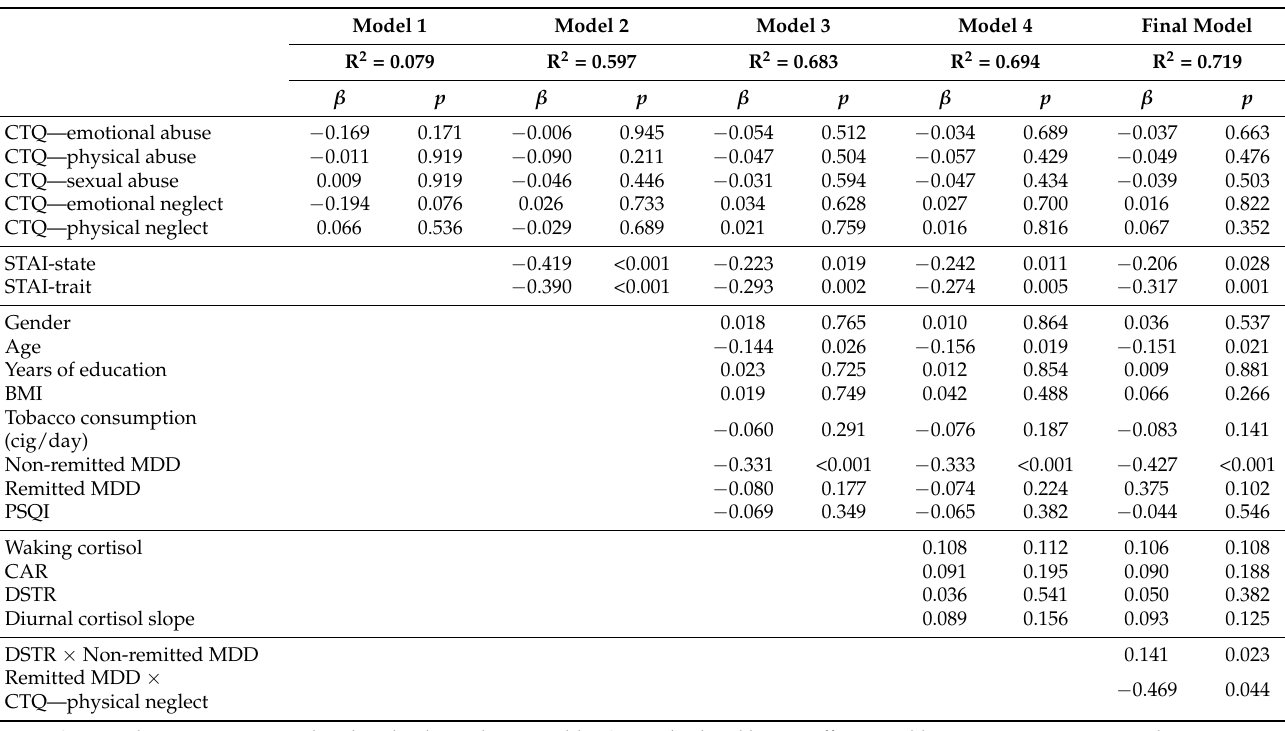
Table 3. Results of multiple linear regression analyses exploring the association of childhood maltreatment, HPA axis function, and MDD remission status with quality of life (EQ-5D-Index scores) in all participants ( n =